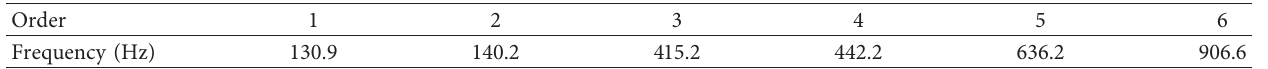
Table 3: The first six-order nature frequency of drive shaft